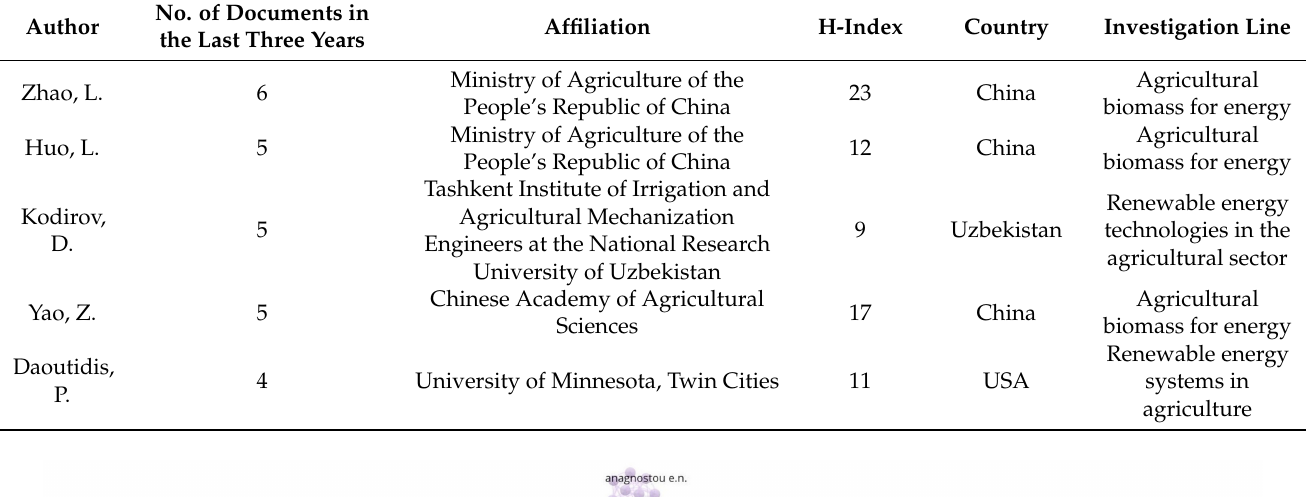
Table 5. Information about the top 5 authors.